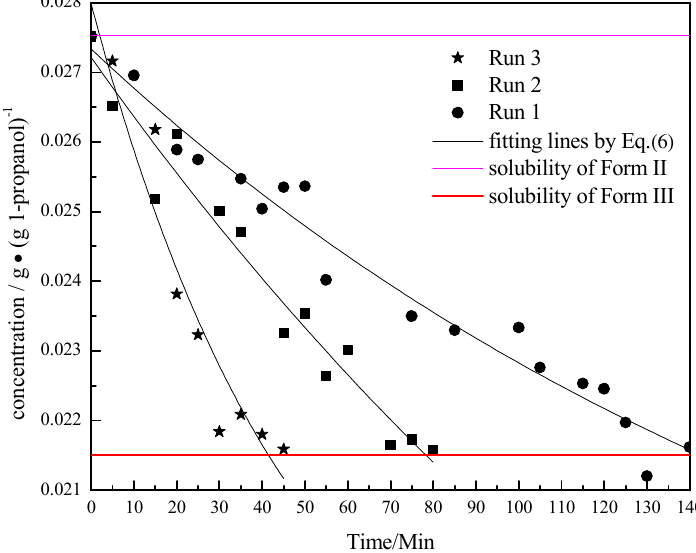
Figure 10. The comparison between the concentration profiles measured by ATR-FTIR during Runs 1, 2 and